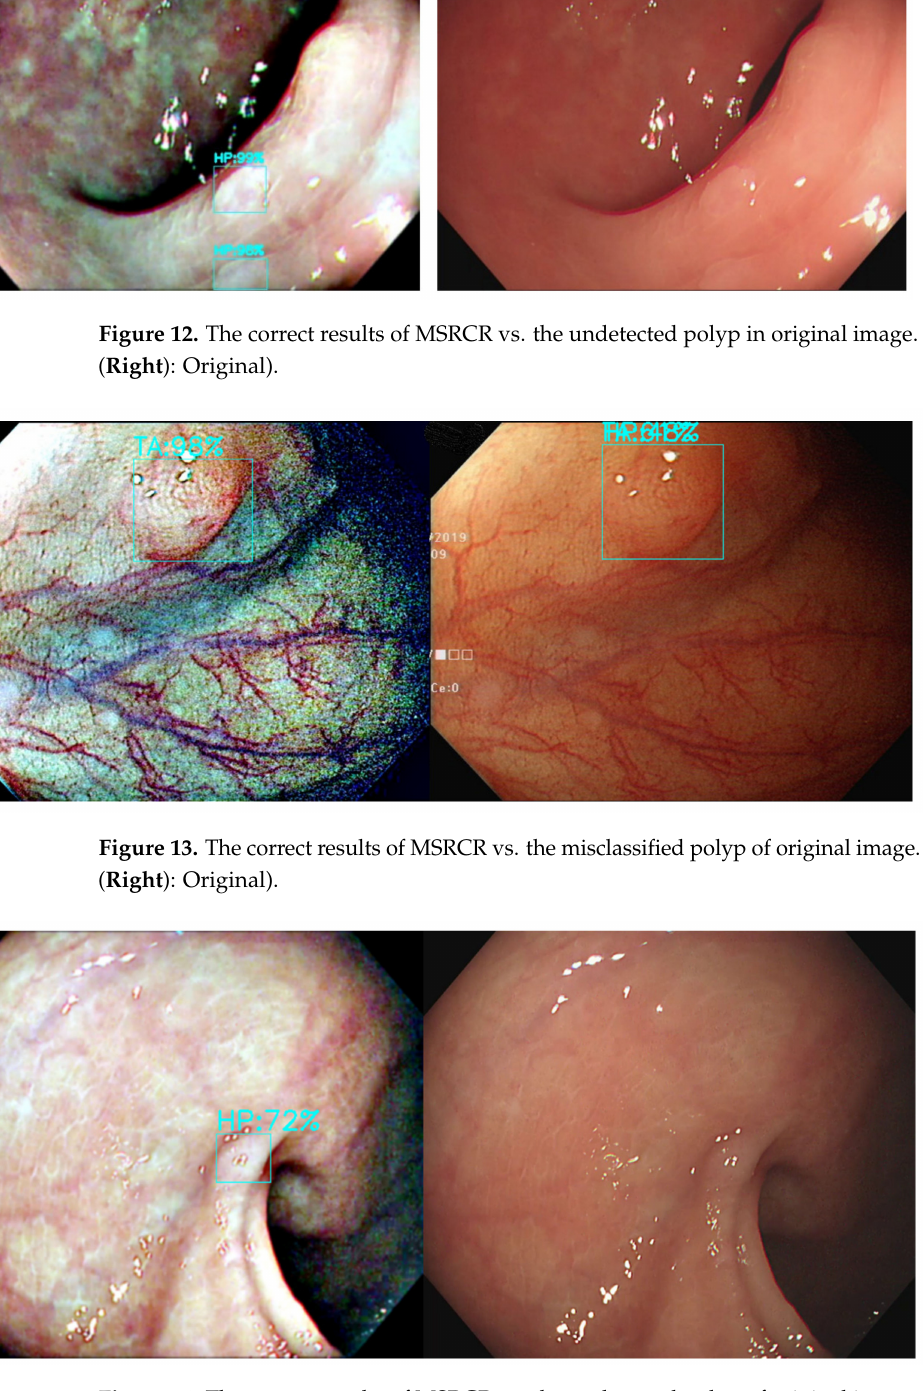
Figure 14. The correct results of MSRCR vs. the undetected polyp of original image. (( Left ): MSRCR, ( Right ):